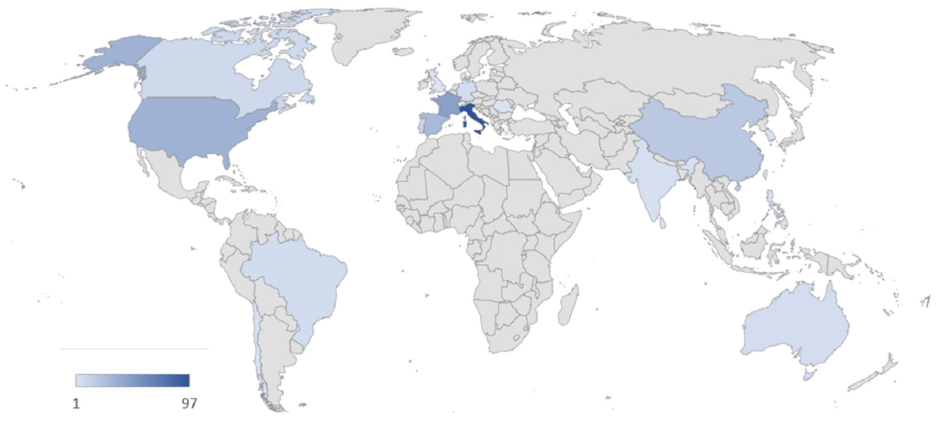
Figure 5. World map distribution of studies measured as the number of author appearances by country affiliation. The intensity of the blue color is proportionate to the number of papers, as indicated by the scale bar on the lower left corner.